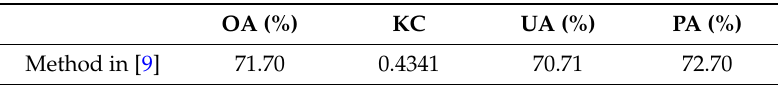
Figure 9. Built-up area extraction using the method in [9], where the white represents the building areas and the black areas are the non-buildings: ( a ) detection results; and ( b ) urban ground truth from NLCD 2006 land cover data, where the red rectangle represents the study area. Table 4. Accuracy assessment of the detection result in Figure